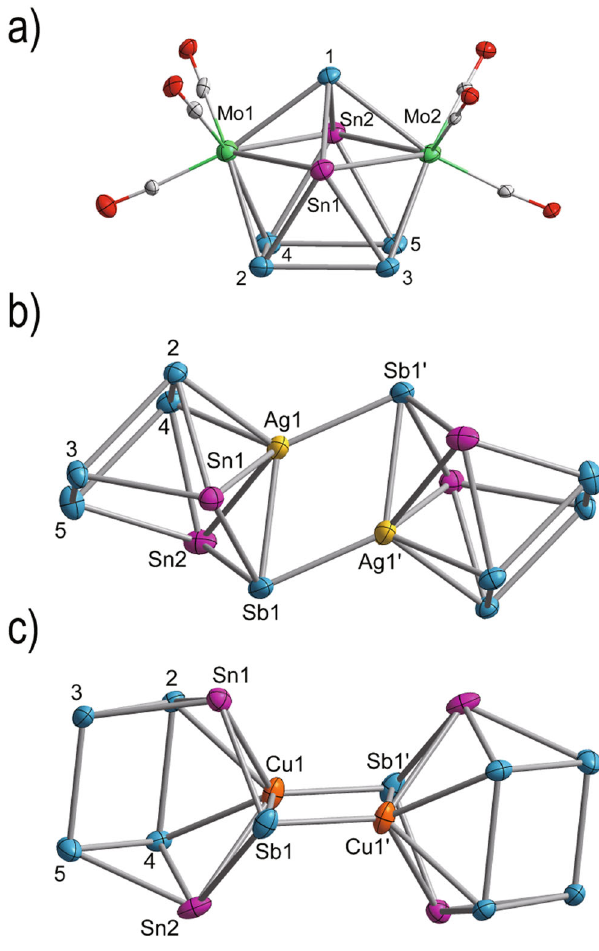
Fig. 3 Ellipsoid plot (50% level) of the crystal structures. a represent front and side views of the same structural type). The ellipsoid colors are as follow: Sn = pink, Sb = blue, Mo = green, Ag = yellow, Cu = orange, C = gray and O = red.